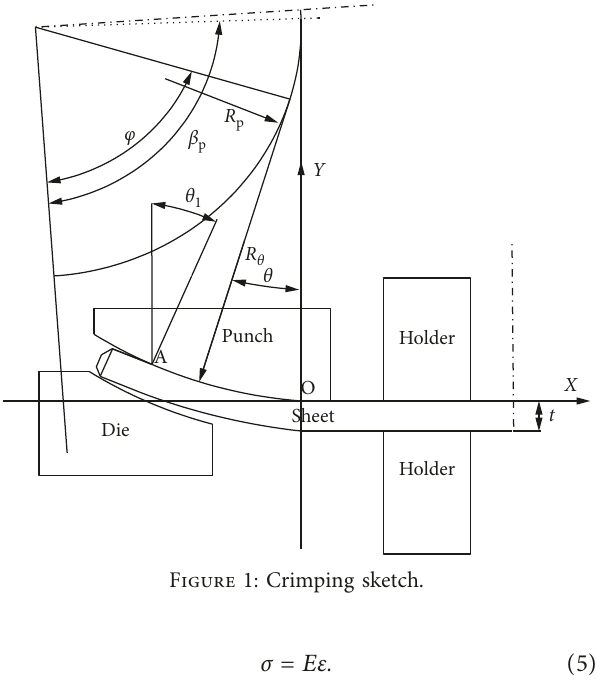
Figure 1: Crimping